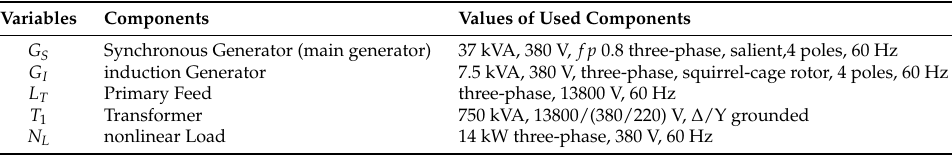
Table 1. Acronyms and values of the components from